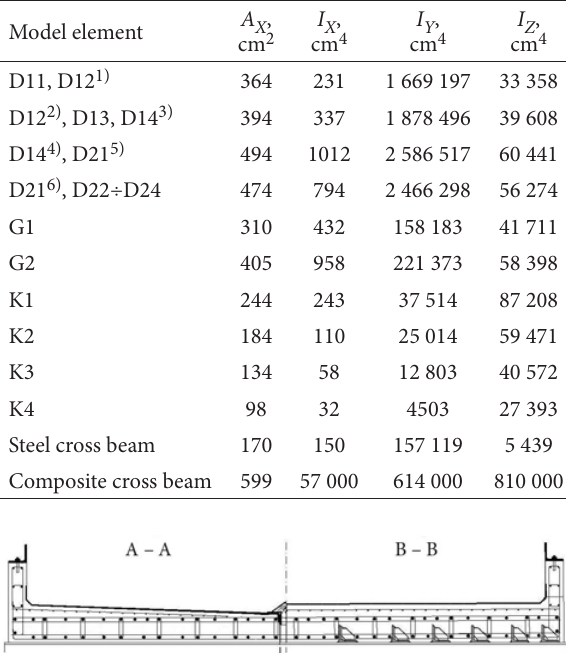
Table 1. Cross-sectional characteristics of bridge members Model element